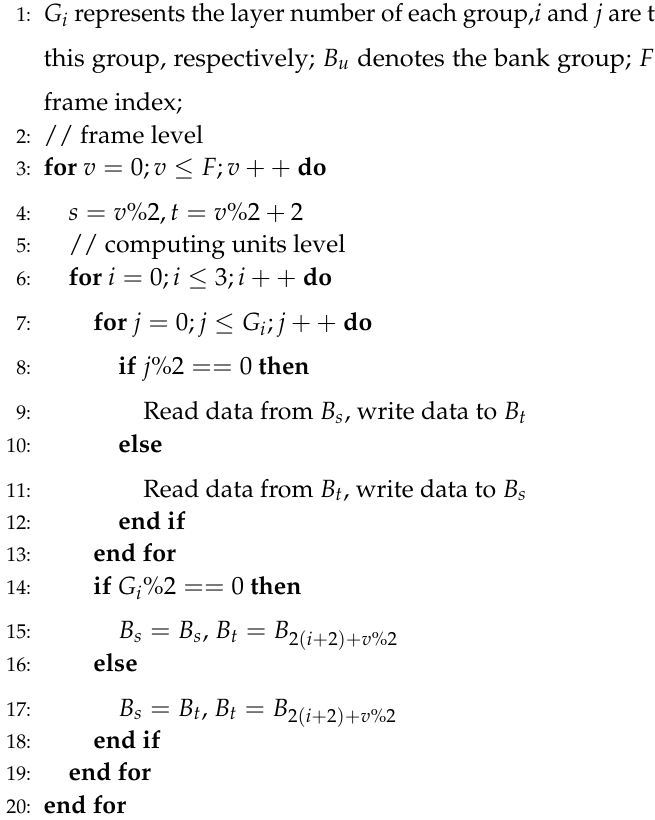
Algorithm 2 Interleaving Bank Scheduling